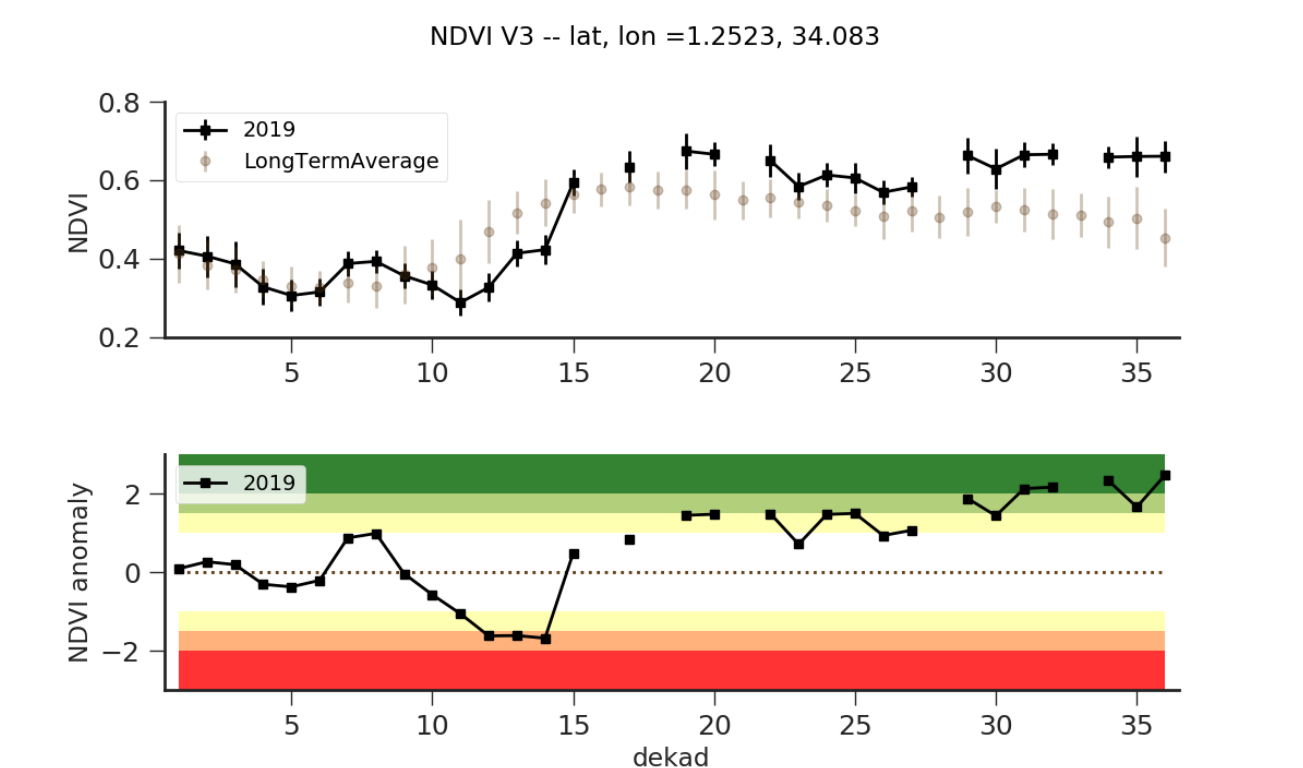
Figure 4. Same as in Figure 3 but Time-Series are extracted from BRDF-adjusted NDVI datasets. Unlike data from the CGLS Collection 1km NDVI Version 2 product, the BRDF-adjusted NDVI datasets provide uncertainties, see 2019 NDVI profile in top